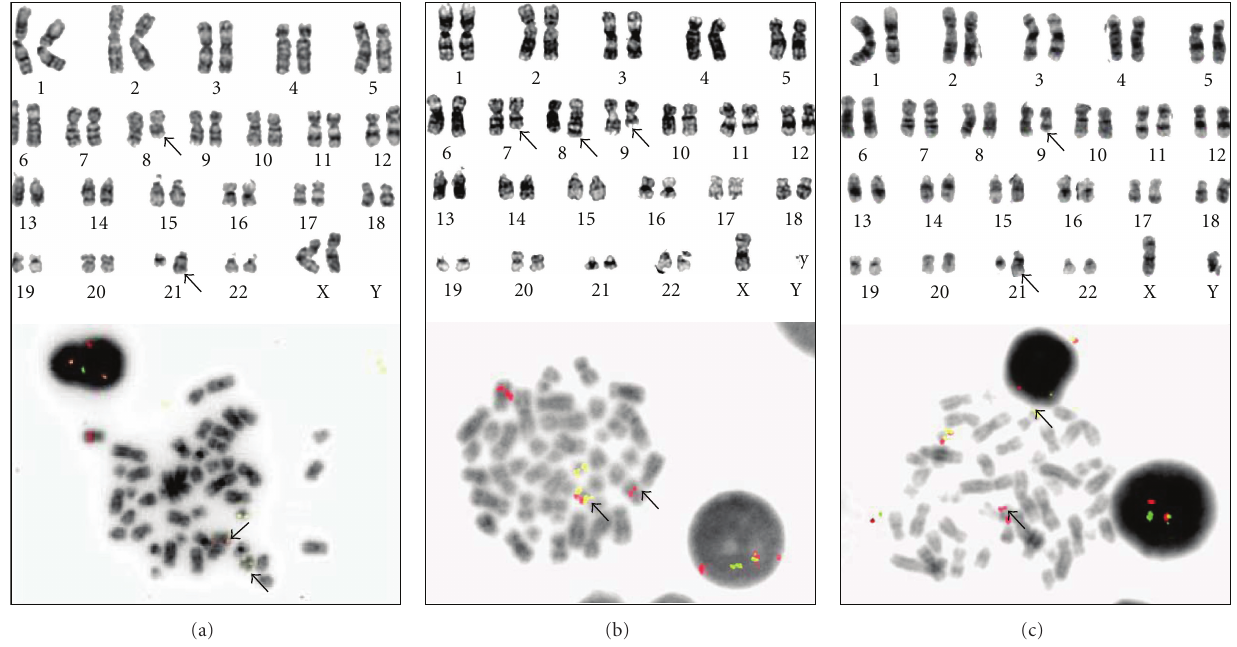
Figure 2: Cytogenetic analysis of AML blasts by G-banding and FISH. (a) The derivative chromosomes from a simple reciprocal translocation between 8q22 and 21q22 are detectable by G-banding (upper panel) and the translocation can be verified using FISH probes (lower panel) against ETO and AML1. With this particular probe (Vysis LSI ETV6(TEL)/RUNX1(AML1) ES Dual Color) fusion signals will appear both on derivative 8 and derivative 22. (b) In rare cases, AML1-ETO fusion occurs as a result of insertion. Smallinsertions can only be detected using FISH probes. In this case, the translocation t(7;8)(q11;q22) between chromosome 7 and 8 and the 9q deletion del(9)(q12q22) were detected. As deletion 9q is rare in AML and can coexist with AML1-ETO fusion, FISH analysis was, therefore, performed. Only one fusion signal on derivative 22 was detected, indicating an ins(21;8)(q22;q22q22) insertion. (c) AML1 can also be involved in translocations with other partners mimicking complex t(8;21). In this case, there is a translocation between 9q22 and 21q22. FISH analysis using in-house split-signal probes against AML1 verified the involvement of these genes, whereas the gene on derivative 9 is